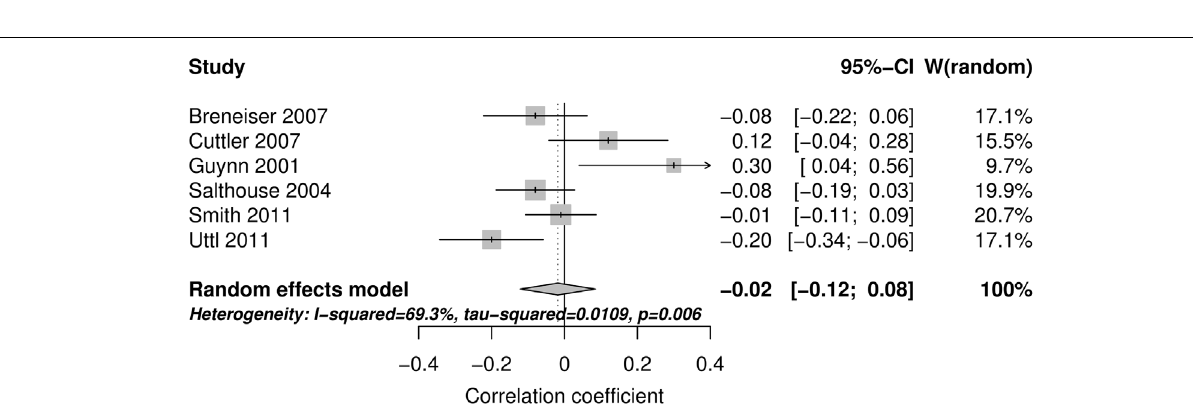
FIGURE 5 |The forest plot and random effect model meta-analysis for agreeableness.